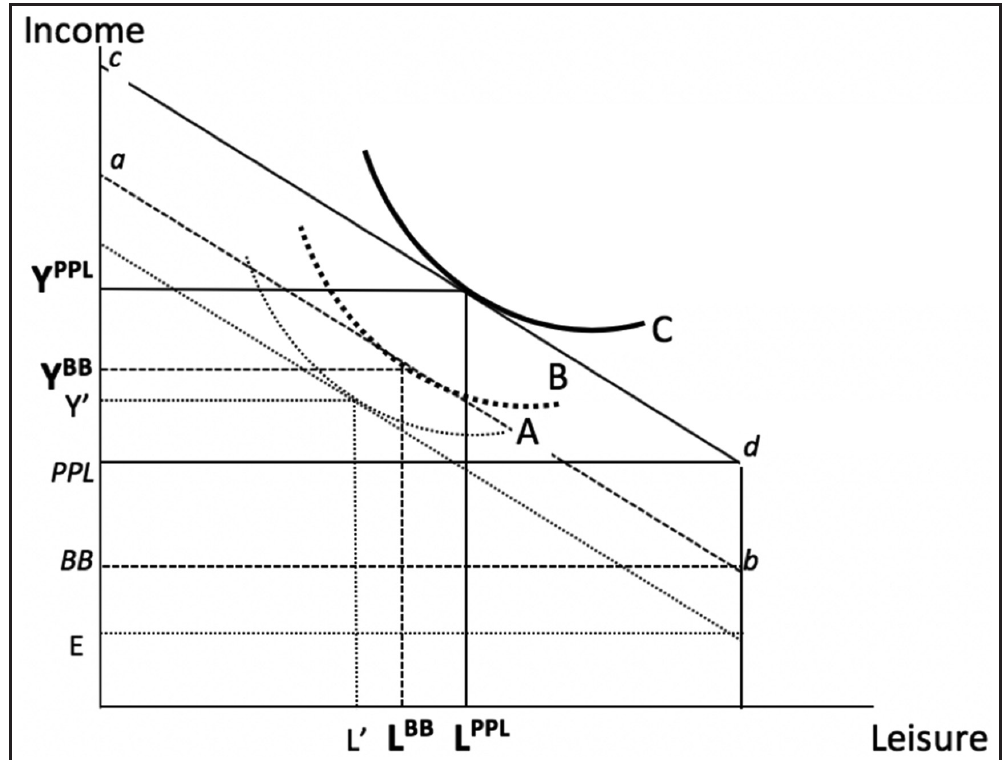
Figure 3 Predicted effect of maternal labor supply post